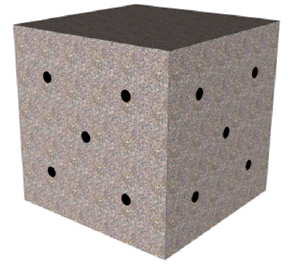
Figure 15. Measuring points.